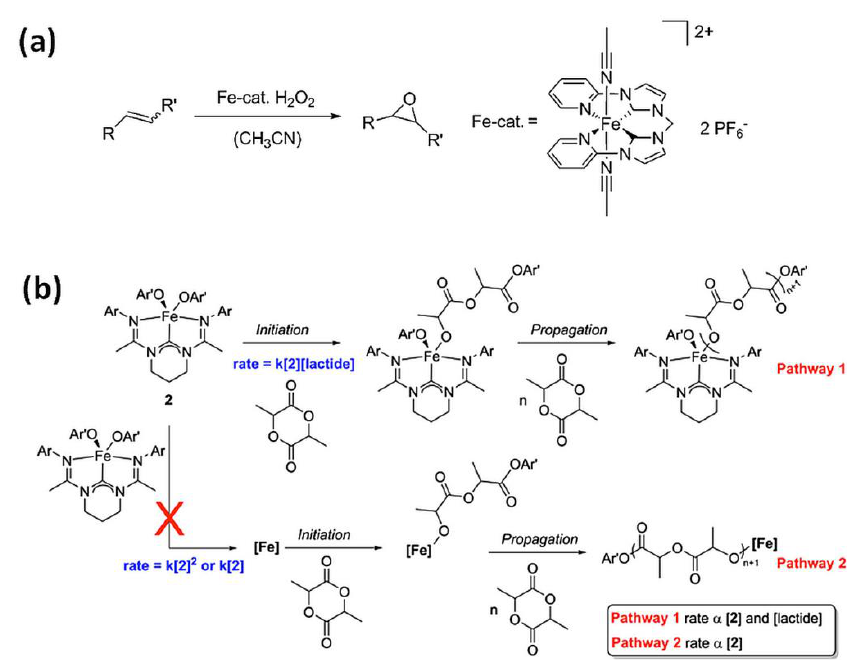
Figure 3. ( a ) Catalytic epoxidation of olefins using N -heterocyclic carbene complex (NCCN) and H 2 O 2 as the oxidant [8]. Reprinted with permission from WILEY-VCH Verlag GmbH & Co. KGaA, Copyright 2014. ( b ) N -heterocyclic carbene complex-(carbenodiamidine)Fe(4-methoxyphenoxide) 2 (2) in polymerization of lactide [55]. Reprinted with permission from Elsevier Ltd., Copyright 2014.